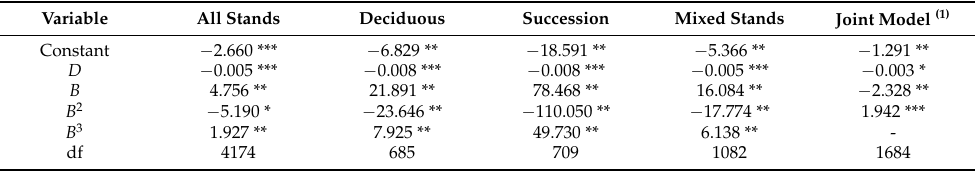
Table 2. Estimated regression parameters of the probit mortality model (Equation (14)).